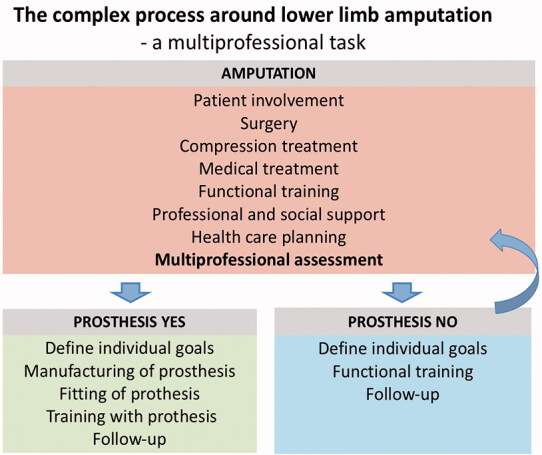
The complex process around lower limb amputation.